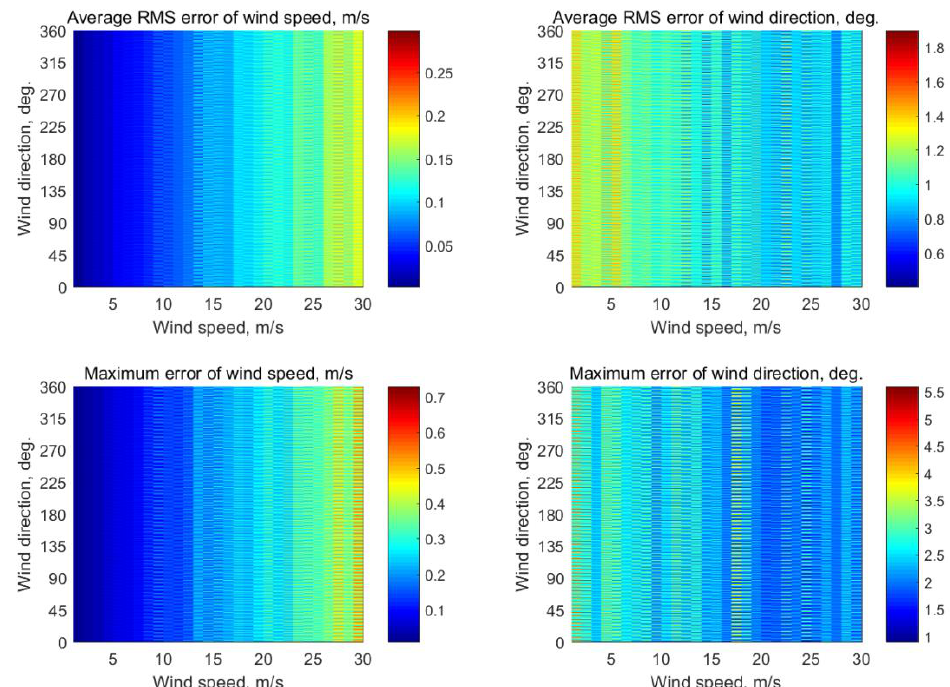
Figure A9. Simulation results of the use of two incidence angles of 35° and 40° for wind retrieval.